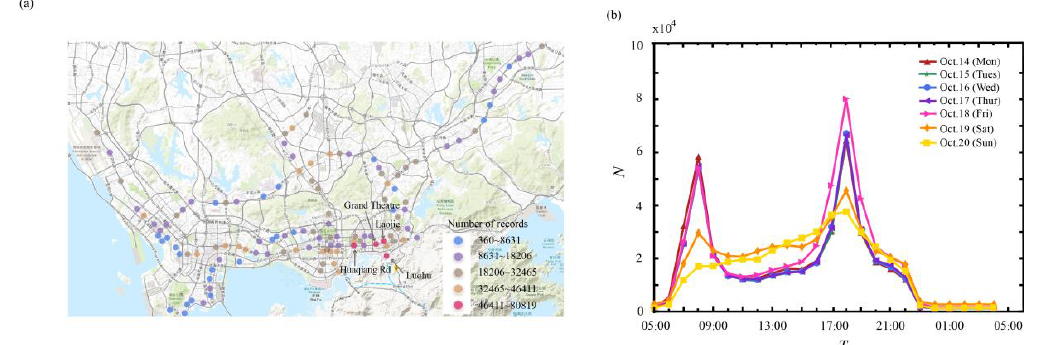
Figure 2. Spatiotemporal distribution of smart card records. ( a ) Spatial distribution of records on 14 October; ( b ) Temporal distribution of hourly records on different days of the week (14 October – 20 October).